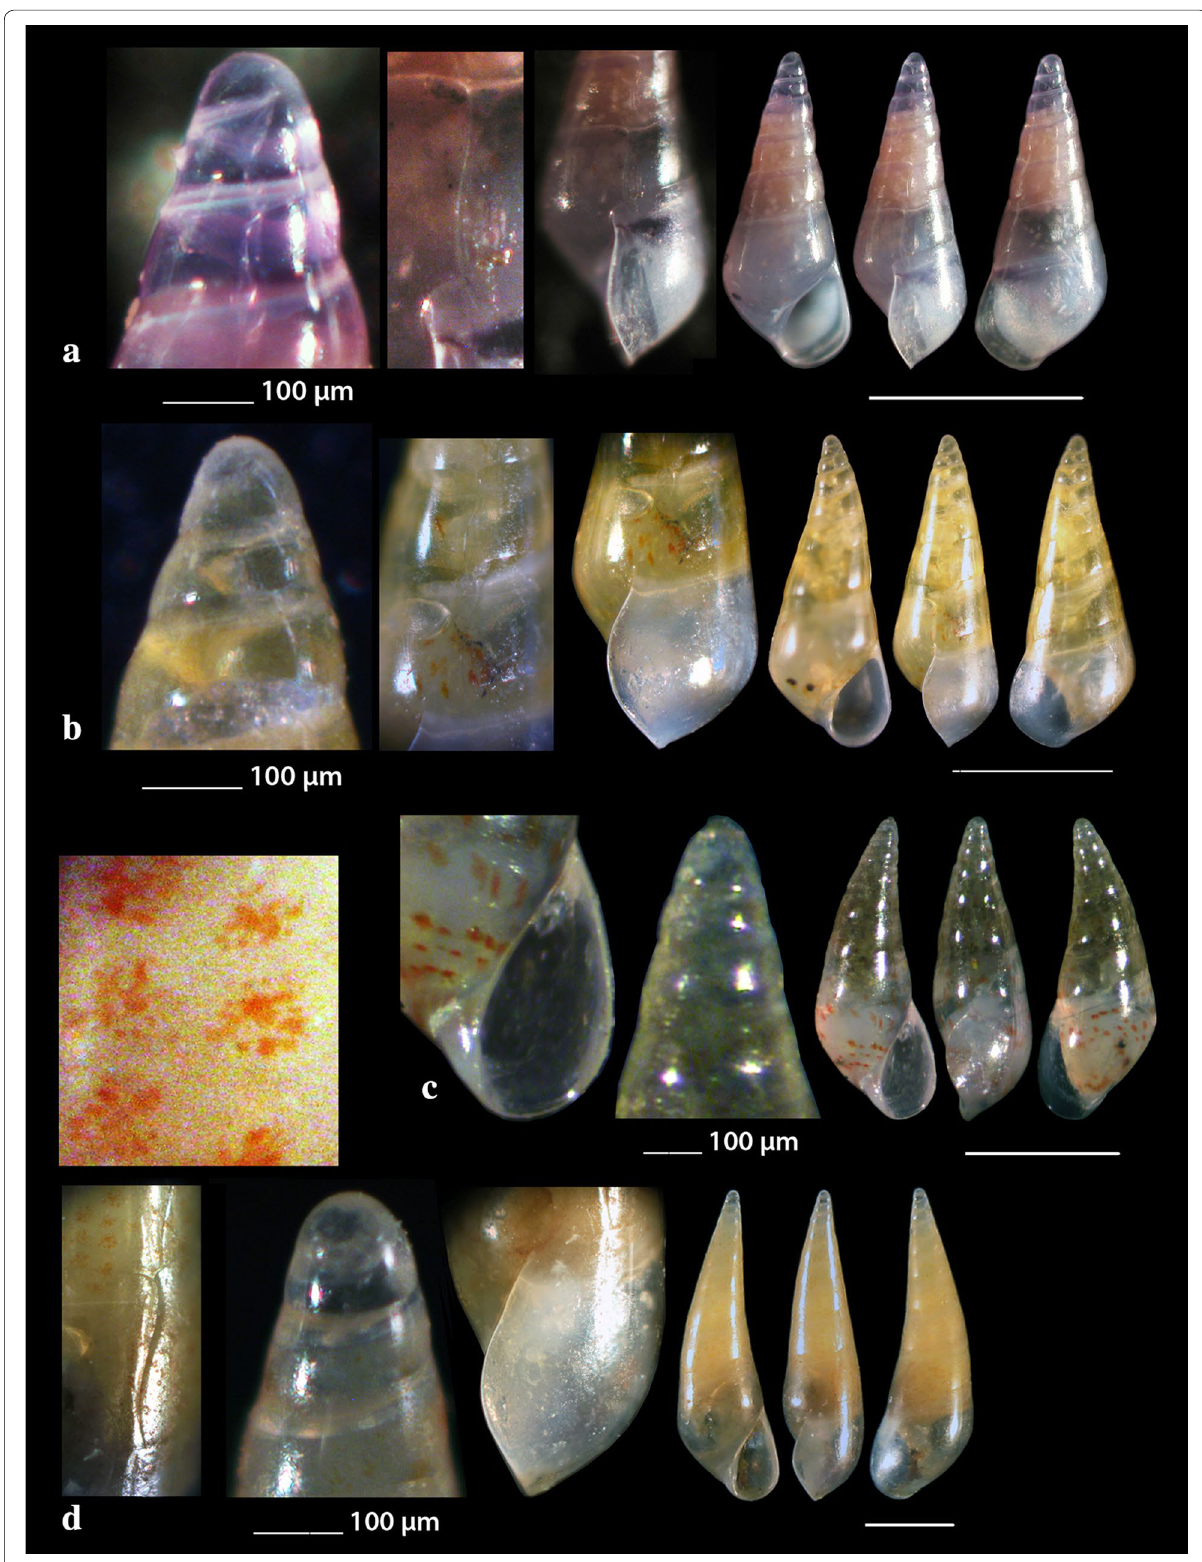
Fig. 19 a Campylorhaphion cf . famelicum , b Melanella spiridioni , c , d Curveulima dautzenbergi . Bar